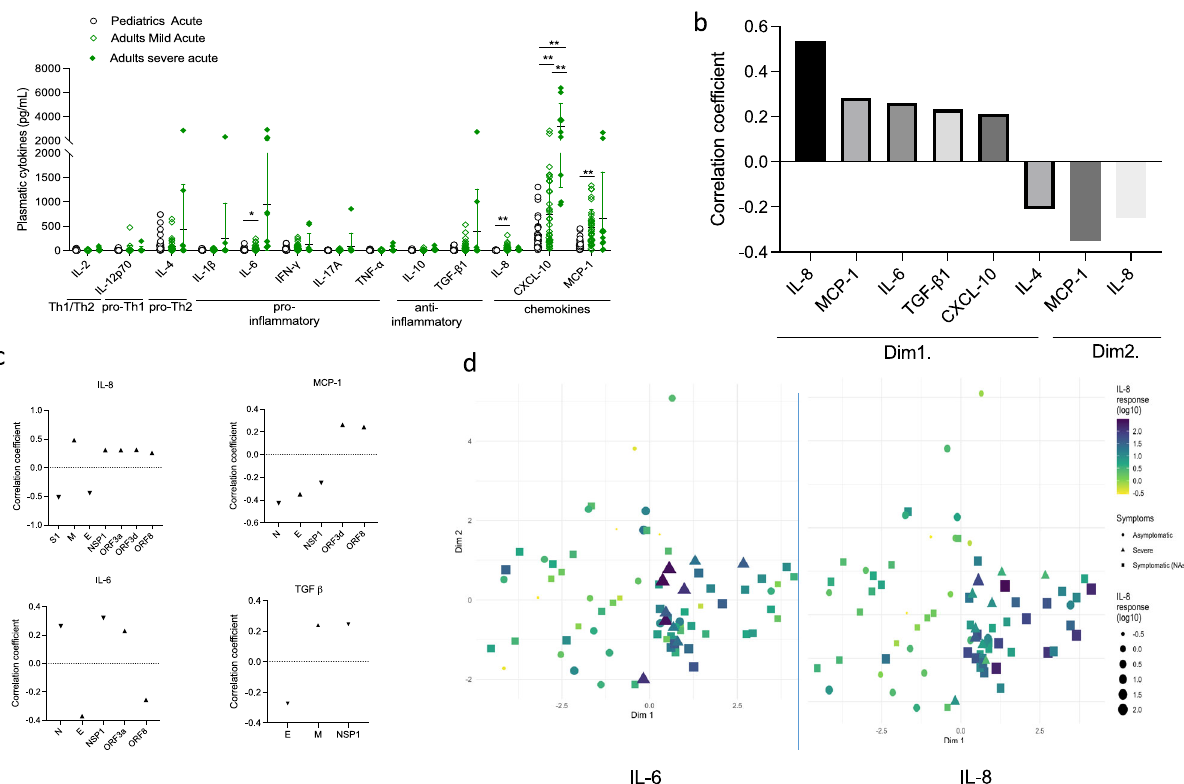
Fig. 7 IL-8 and MCP-1 contribute the biggest determinate of the COVID-19 antibody responses, and IL-6 and IL-8 are associated with disease severity of antibody responses. a Plasma levels of 13 circulating cytokines in pg/mL for acute samples (<day 7) for pediatric cases ( n = 35) or adults mild ( n = 34) and severe cases ( n = 10): IL-2, IL-12p70, IL-4, IL-1 β , IL-6, IFN- γ , IL-17A, TNF- α , IL-10, TGF- β 1, IL-8, CXCL-10, MCP-1. Data represent individual cytokine responses and mean ± stdev. For pediatrics versus adults mild: p = 0.0019 for IL-8, p = 0.0078 for CXCL10, p < 0.0001 for MCP-1. b Highest correlation coef fi cient of cytokines with Dim-1 and Dim-2 of the antibody responses from Fig. 3. c Correlation coef fi cients of speci fi c antigens with the cytokines of interest IL-8, MCP-1, IL-6, and TGF- β . d Association of IL-6 and IL-8 levels with clinical symptoms in Dim-1 and Dim-2 of the antibody responses from Fig. 3. Severe (triangles) and mild (square) cases are darker than asymptomatic cases and located on the right of the graph meaning that they strongly associated with Dim-1 (( p < 0.05 and p < 0.0001, respectively). Data were analyzed using the two-sample Wilcoxon test for comparison of the responses between asymptomatic and symptomatic